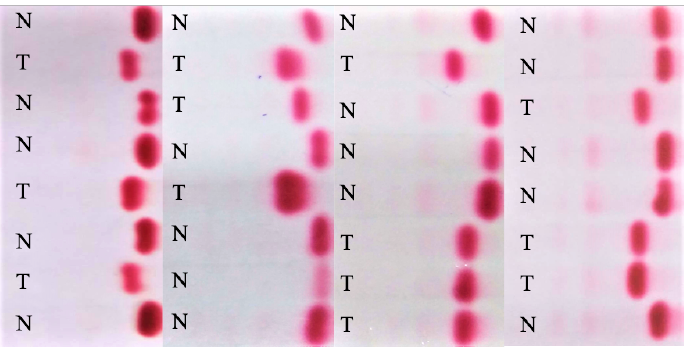
Figure 4. Sample electrophoresis raw images from the dataset.